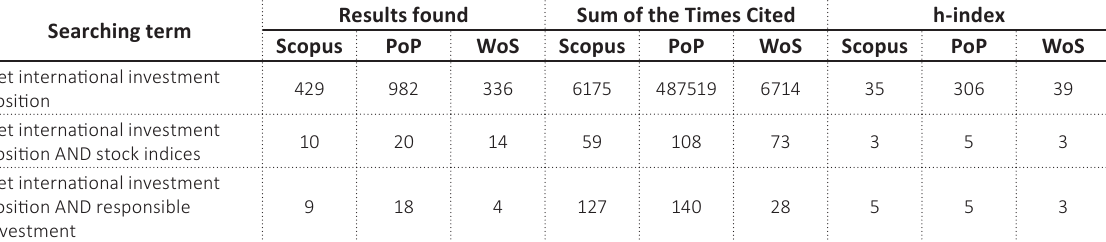
Table 1. Static analysis of the net investment position and other queries in academic literature for the period 2000–2021 as of January 25,